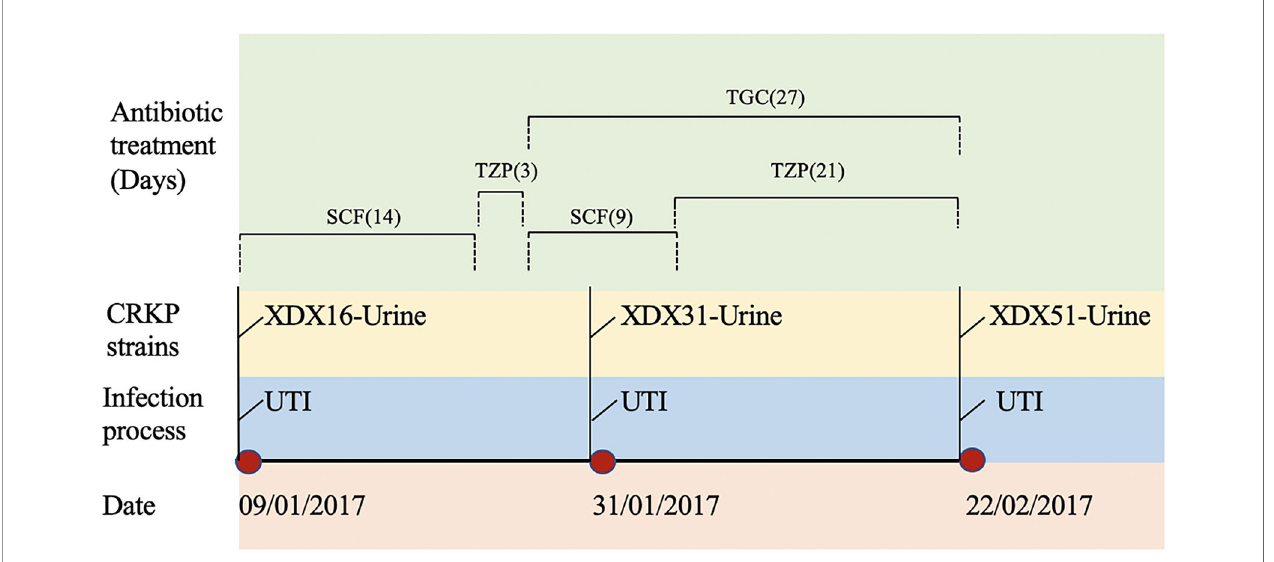
FIGURE 1 | Timeline of CRKP infection and treatment during the patient ’ s hospitalization. XDX16, XDX31 and XDX51 are carbapenem-resistant Klebsiella pneumoniae strains. UTI, urinary tract infection; SCF, Cefoperazone-sulbactam; TZP, Piperacillin-tazobactam; TGC,